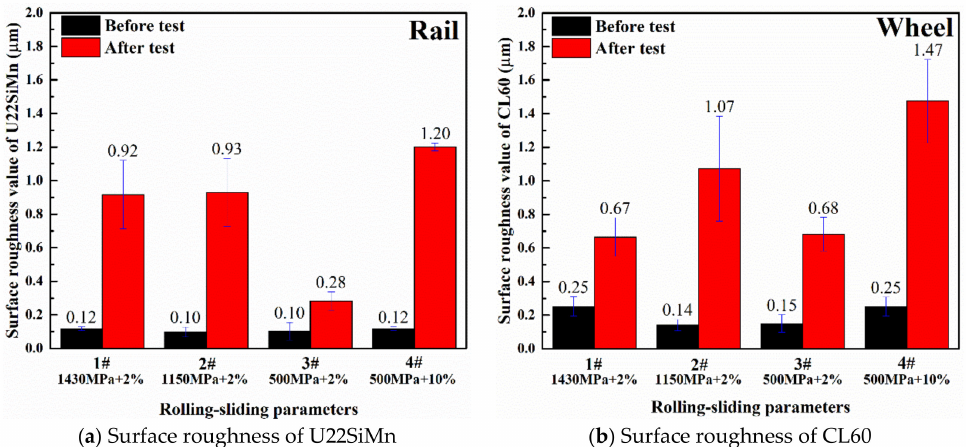
Figure 5. The roughness values of bainitic steel and CL60 wheel before and after wear tests.